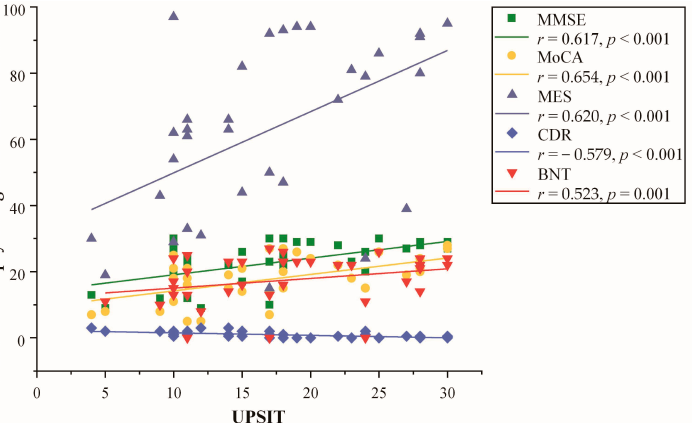
Figure 1. Pearson correlation between the University of Pennsylvania Smell Identification Test (UP- SIT) scores and clinical neuropsychological examination scores in two groups; p < 0.05 was the sta- tistical test analysis result of Pearson